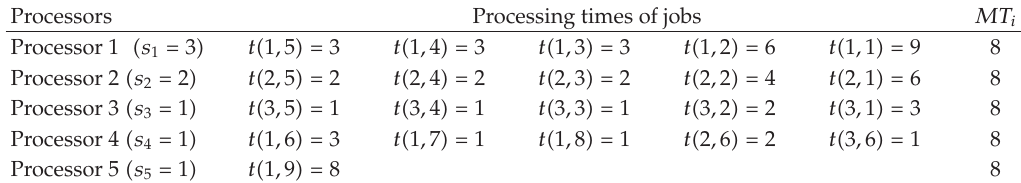
Table 4: The optimal